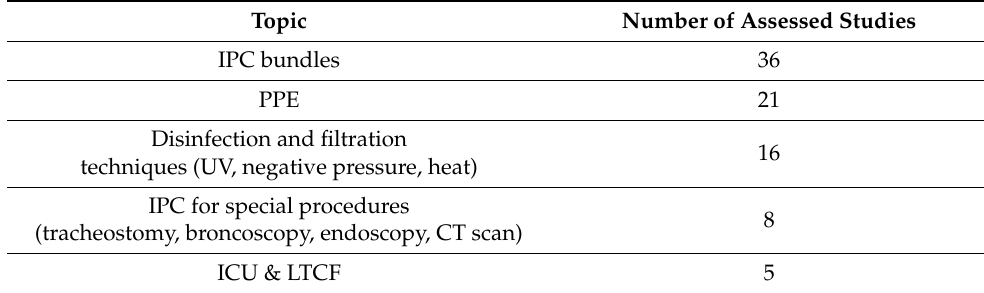
Figure 1. Flow-chart of studies screened and included in the analysis. Table 1. Types of included studies (guidelines and empirical research).